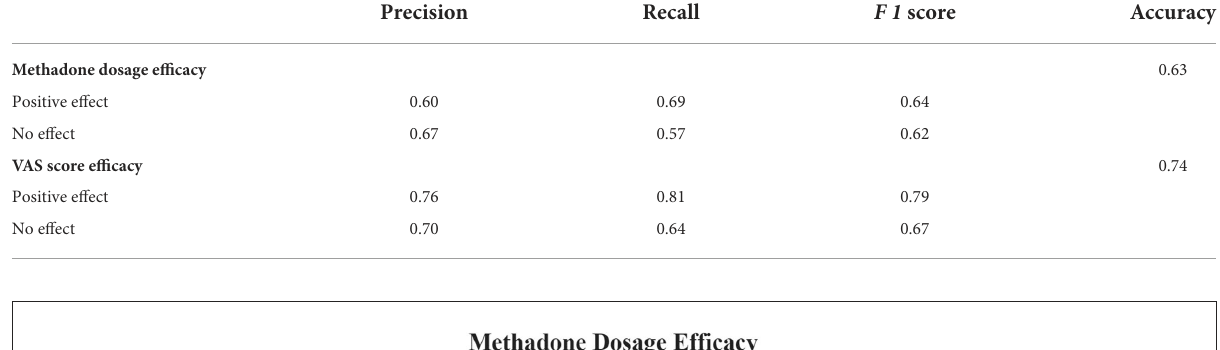
TABLE 3 P-R value and F 1 score for each class.